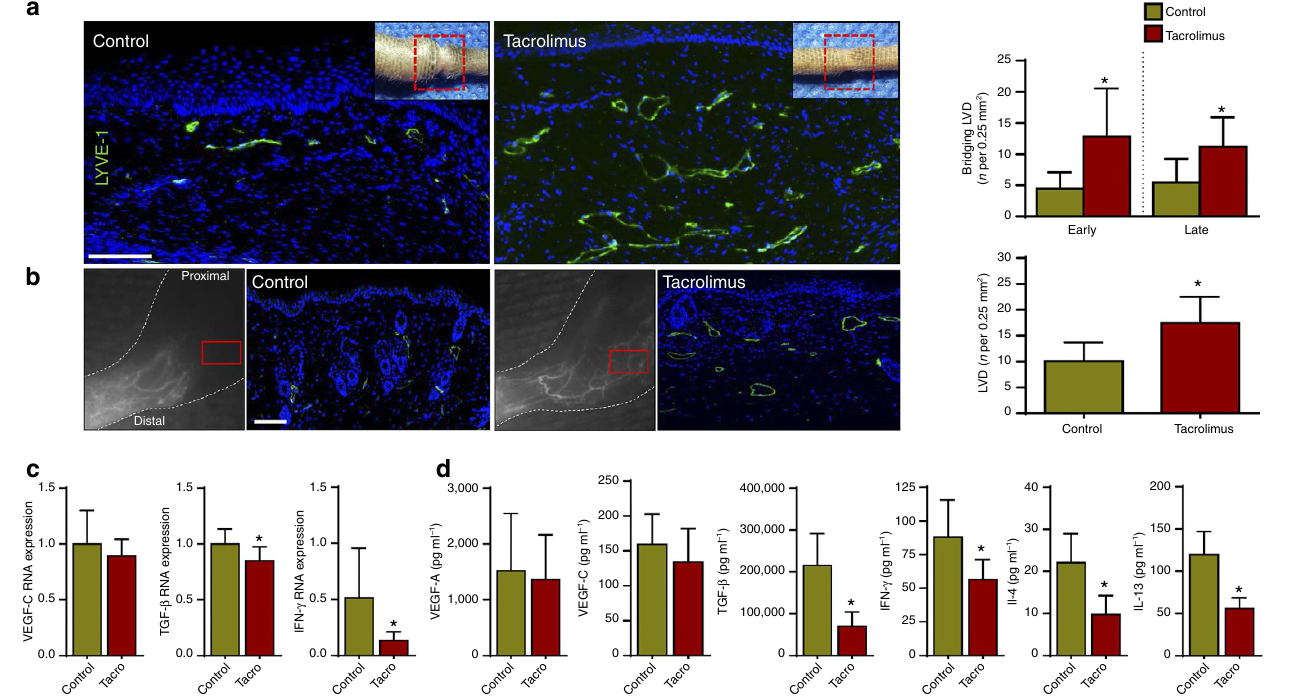
Figure 5 | Topical tacrolimus increases formation of collateral lymphatic vessels. ( a ) Left panel: representative longitudinal immunofluorescent (cid:3) 40 images of LYVE-1 vessels (green) bridging the surgically created tail wounds of control and early-treated tacrolimus mice harvested 6 weeks after lymphatic injury; inset shows area where longitudinal sections were obtained. Right panel: quantification of bridging lymphatic vessel density (LVD) in the wounded portion of the tail in control versus early or late-treated tacrolimus mice ( P o 0.001 for both; n ¼ 6/group). ( b ) Left panel: representative ICG (left panels) and (cid:3) 40 immunofluorescent images of LYVE-1 þ vessels (right panel showing area in red box) in control and tacrolimus-treated animals 4 weeks following PLND. Right panel: quantification of collateral lymphatic LVD in the anterolateral thigh region of animals treated with control or tacrolimus ( P o 0.001; n ¼ 6/group). ( c ) qPCR of RNA harvested from control and early-treated tacrolimus mouse tail tissues harvested 6 weeks after lymphatic injury, demonstrating relative expression of VEGF-C ( P ¼ 0.264), TGF- b 1 ( P ¼ 0.006) and IFN- g ( P ¼ 0.022; n ¼ 6/group). ( d ) Protein concentrations from hindlimb tissues for each group using enzyme-linked immunosorbant assay for VEGF-A ( P ¼ 0.711), VEGF-C ( P ¼ 0.233), TGF- b 1 ( P o 0.001), IFN- g ( P ¼ 0.022), IL-4 ( P ¼ 0.034) and IL-13 ( P ¼ 0.009; n ¼ 6/group). Experiments were repeated two to three times. All data